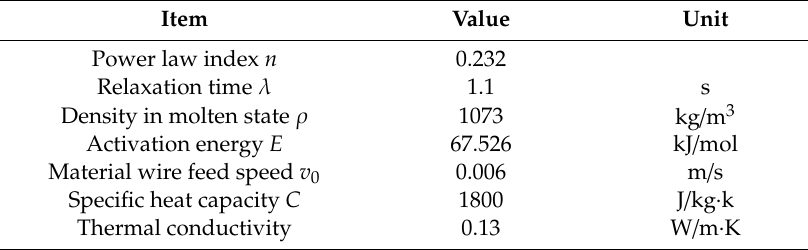
Table 2. Physical properties of polylactic acid (PLA)